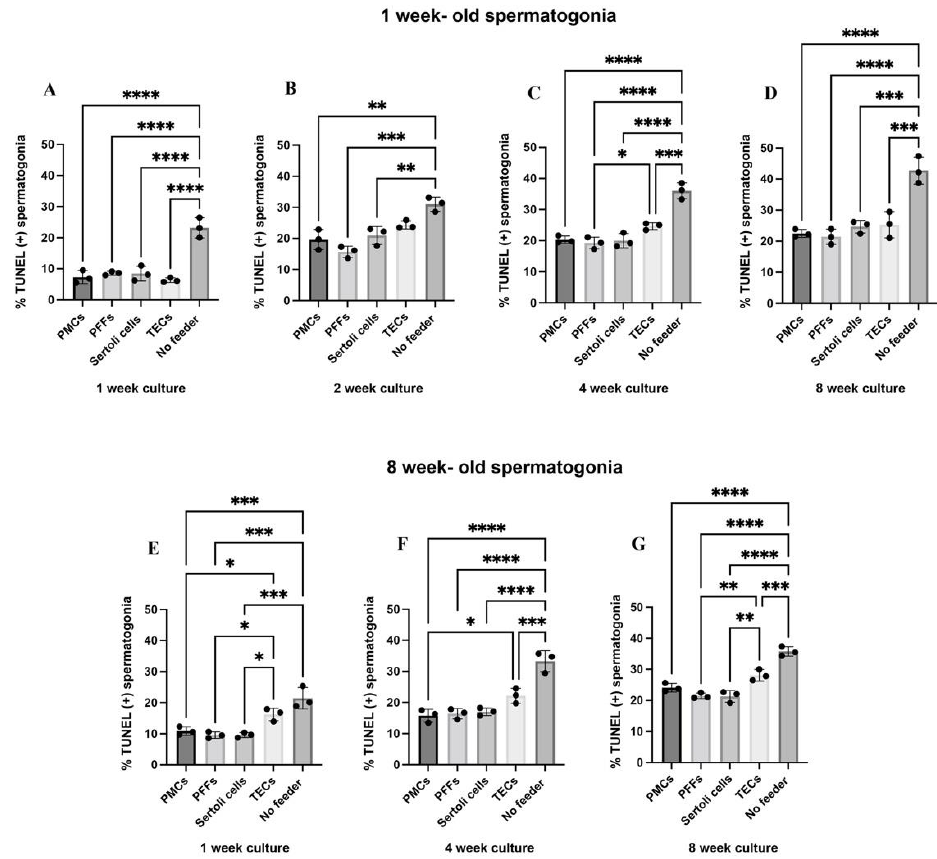
Figure 3. Co-culture with PMCs, PFFs, and Sertoli cells reduced apoptosis of spermatogonia. Per- cent of UCH-L1 (+) spermatogonia from one-week-old pigs that are also TUNEL (+), in co-culture conditions at one week ( A ), two weeks, ( B ), four weeks ( C ), and eight weeks ( D ) of culture. Percent of UCH-L1 (+) spermatogonia from eight-week-old pigs that are also TUNEL (+), in co-culture con- ditions at one week ( E ), four weeks ( F ), and eight weeks ( G ) of culture. Data are presented as mean ± SD (n = 3). A p -value of < 0.05 was considered significant (* p ≤ 0.05, ** p ≤ 0.01, *** p ≤ 0.001, **** p ≤ 0.0001).